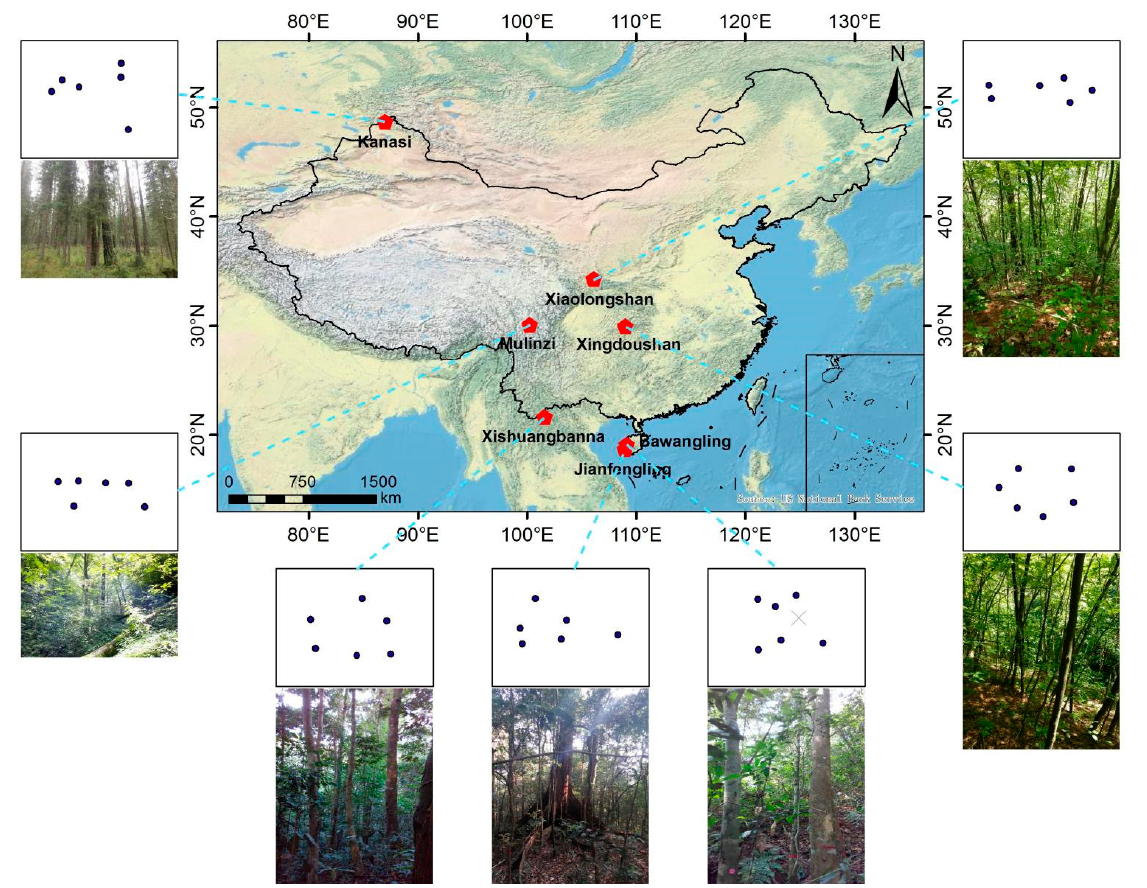
Figure A1. Geographical distribution of the 309 plots. Plots were taken from seven forest sites in China. At each site, plots with an area of 20 m × 20 m were randomly established.